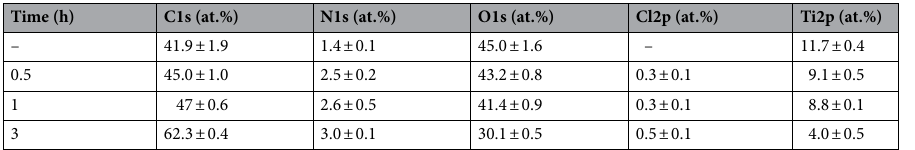
Time (h) C1s (at.%) N1s